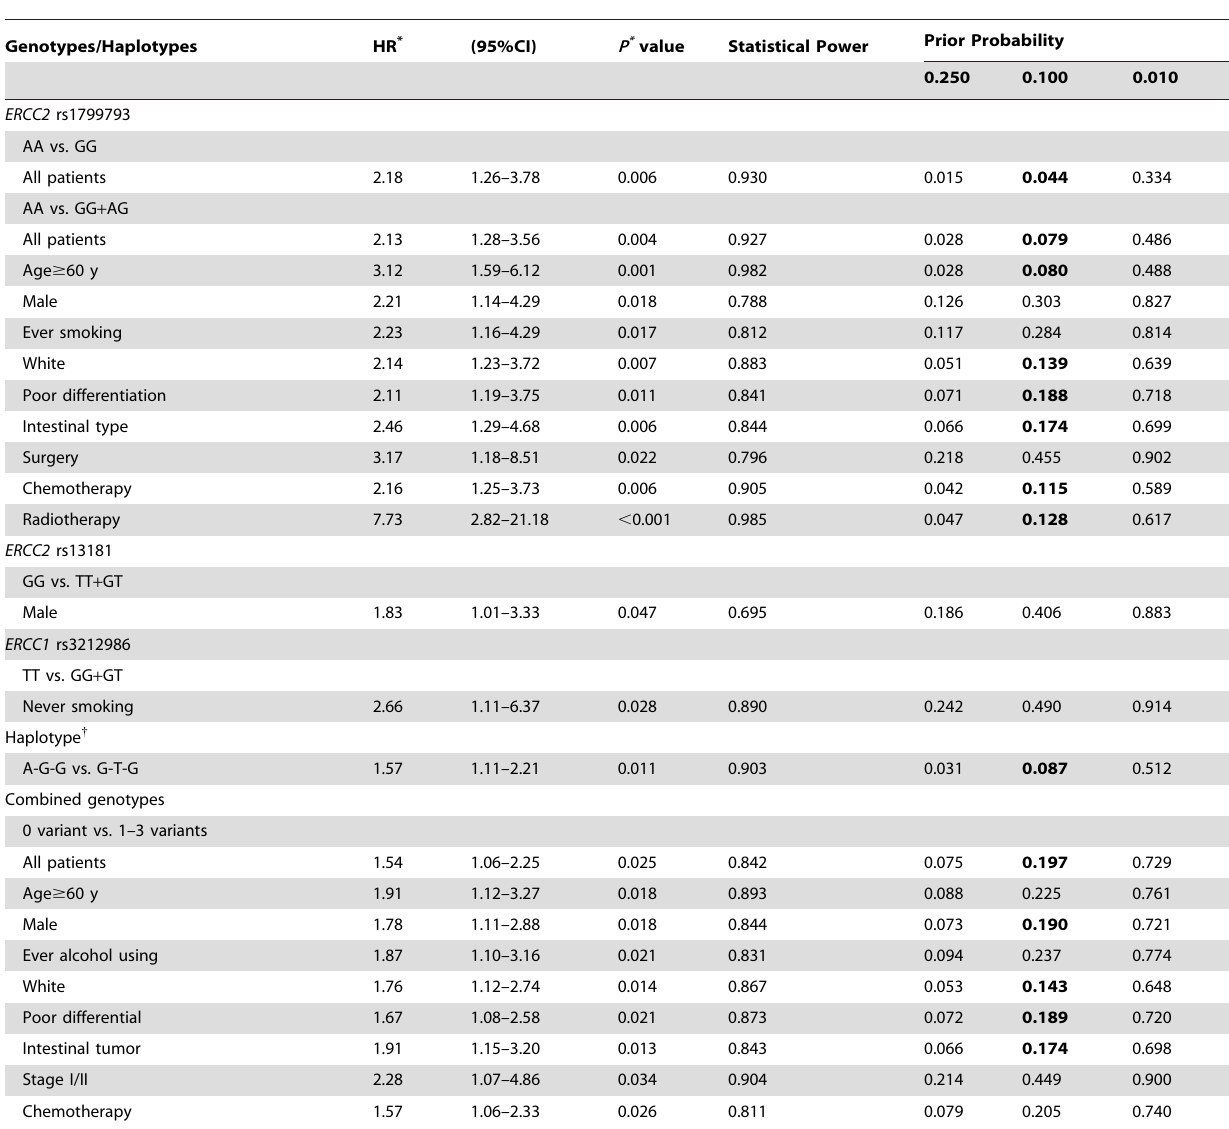
Table 5. False-positive report probability for Association between overall survival in gastric cancer patients and the genotypes and haplotypes of ERCC1 and ERCC2